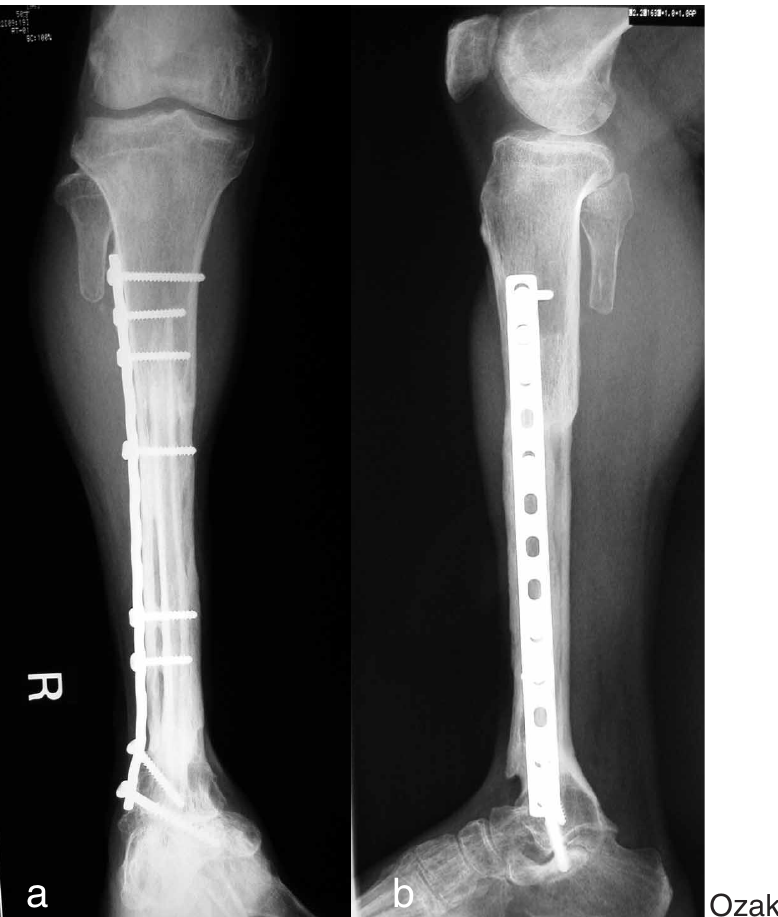
Fig. 3. Case 1 . Radiograph taken at 5 years after operation. The junction site of bone healed completely. (a) Antero-posterior view; (b) lateral view.